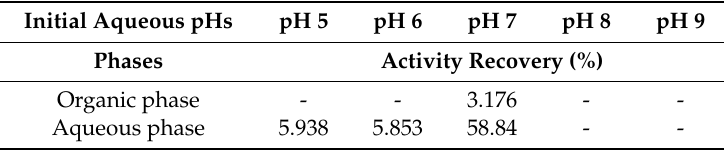
Table 1. Effect of the initial aqueous pH on the forward extraction (organic phase) and the backward extraction (aqueous phase) in the Triton X-100/toluene reverse